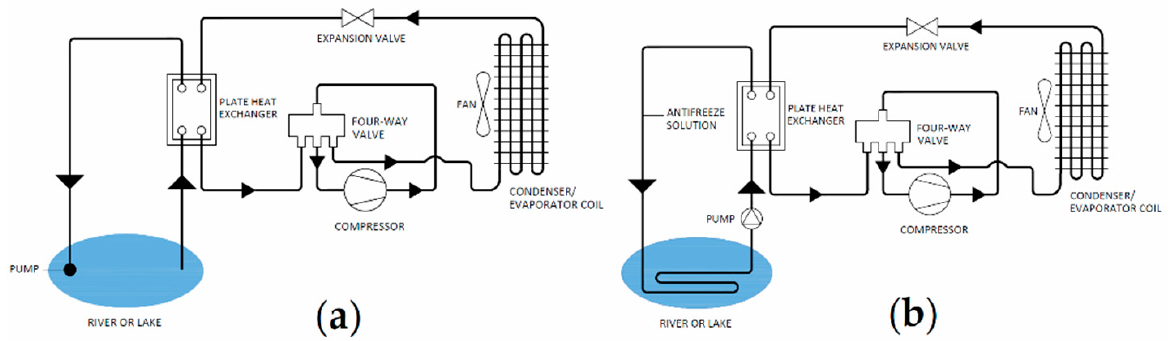
Figure 9. The schematic of ( a ) the open-loop SWHP and ( b ) the closed-loop SWHP in heating